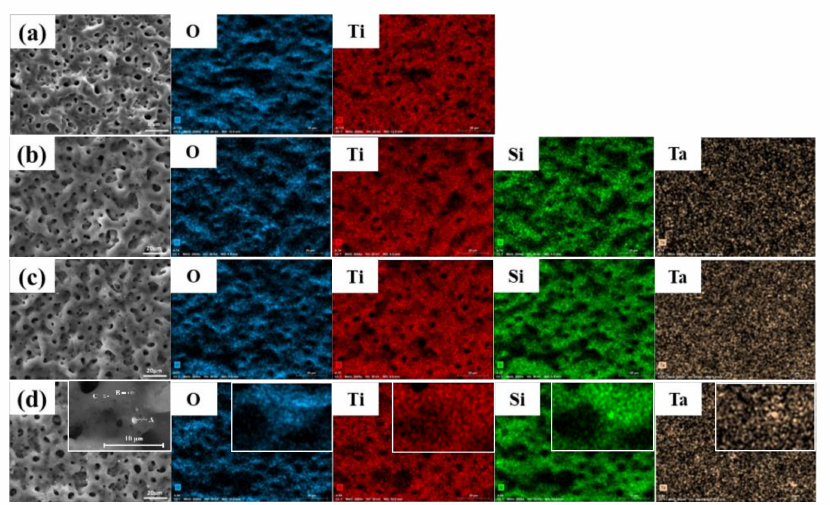
Figure 4. EDS mappings of the MAO coatings with different concentration of Si 3 N 4 /TaC particles: